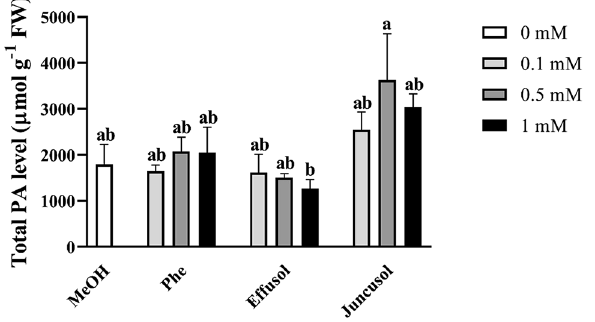
Figure 12. Total free PAs of seedlings treated with Phe, effusol and juncusol at different concentrations compared to MeOH. Data are presented as the mean ± SE (n = 3). Different letters indicate significant differences between the values of the treatments (P < 0.05) analysed by Tukey’s post-hoc